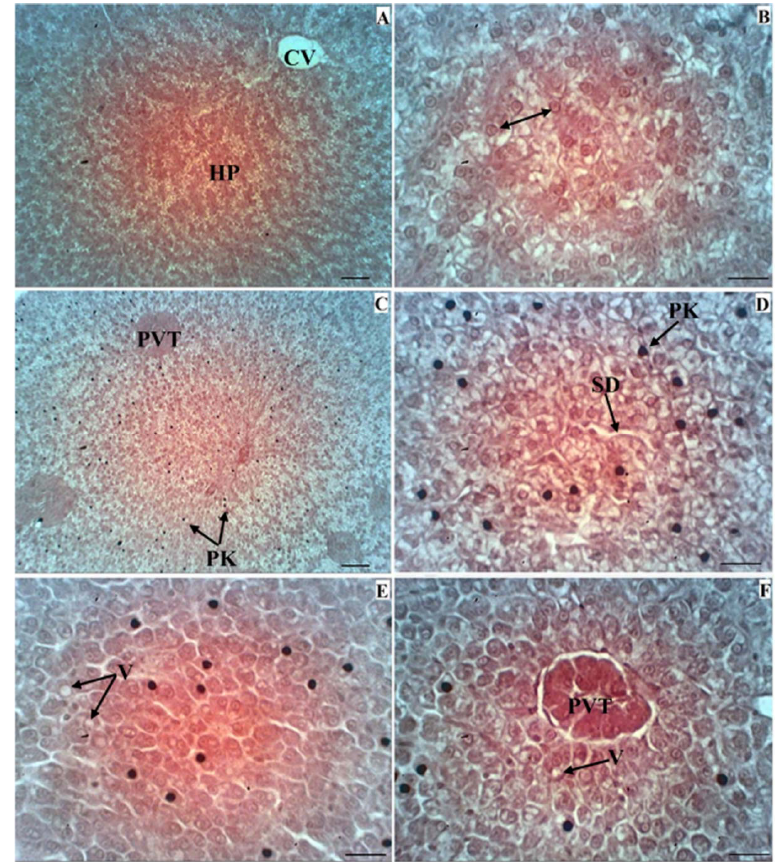
Fig. 2: Transverse sections showing the histopathology of livers with fipronil exposures in the first week of sampling. A (×725) and B (×2900) Paranchymal structure of hepatocytes in the control group with the central vein (CV) and normal nuclei. C (×725) and D (×2900) Pyknotic nuclei (PK) and sinusoid dilation (SD) in hepatocytes along with pancreatic-venous tracts (PVT) in the 65 mg/kg group. E (×2900) and F (×2900) Vacuolization (V) in hepatocytes in the 130 and 200 mg/kg groups, respectively. H&E, scale bar: 0.05 mm (A and C) and 0.02 mm (B, D, E and F).